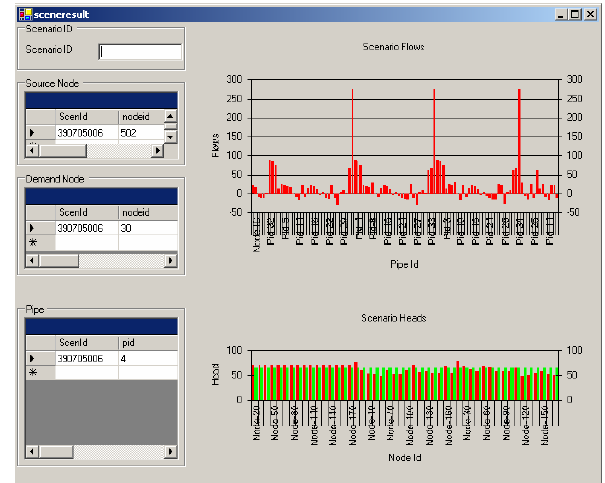
Figure 14. Existing scenario results of Simulation Fig. 14. Existing scenario results of Simulation module